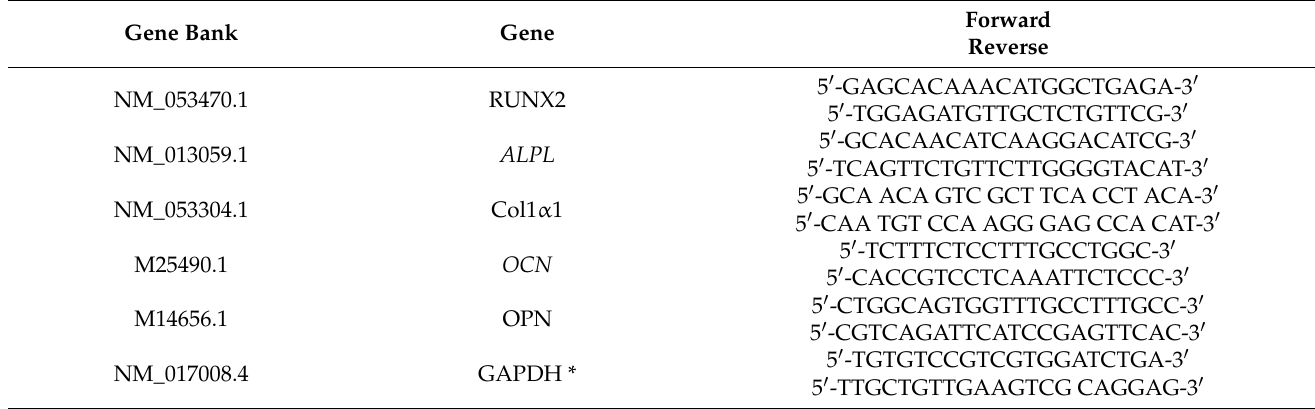
Table 1. Primer sequences used in this study for qRT-PCR assessment. Gene Bank Gene